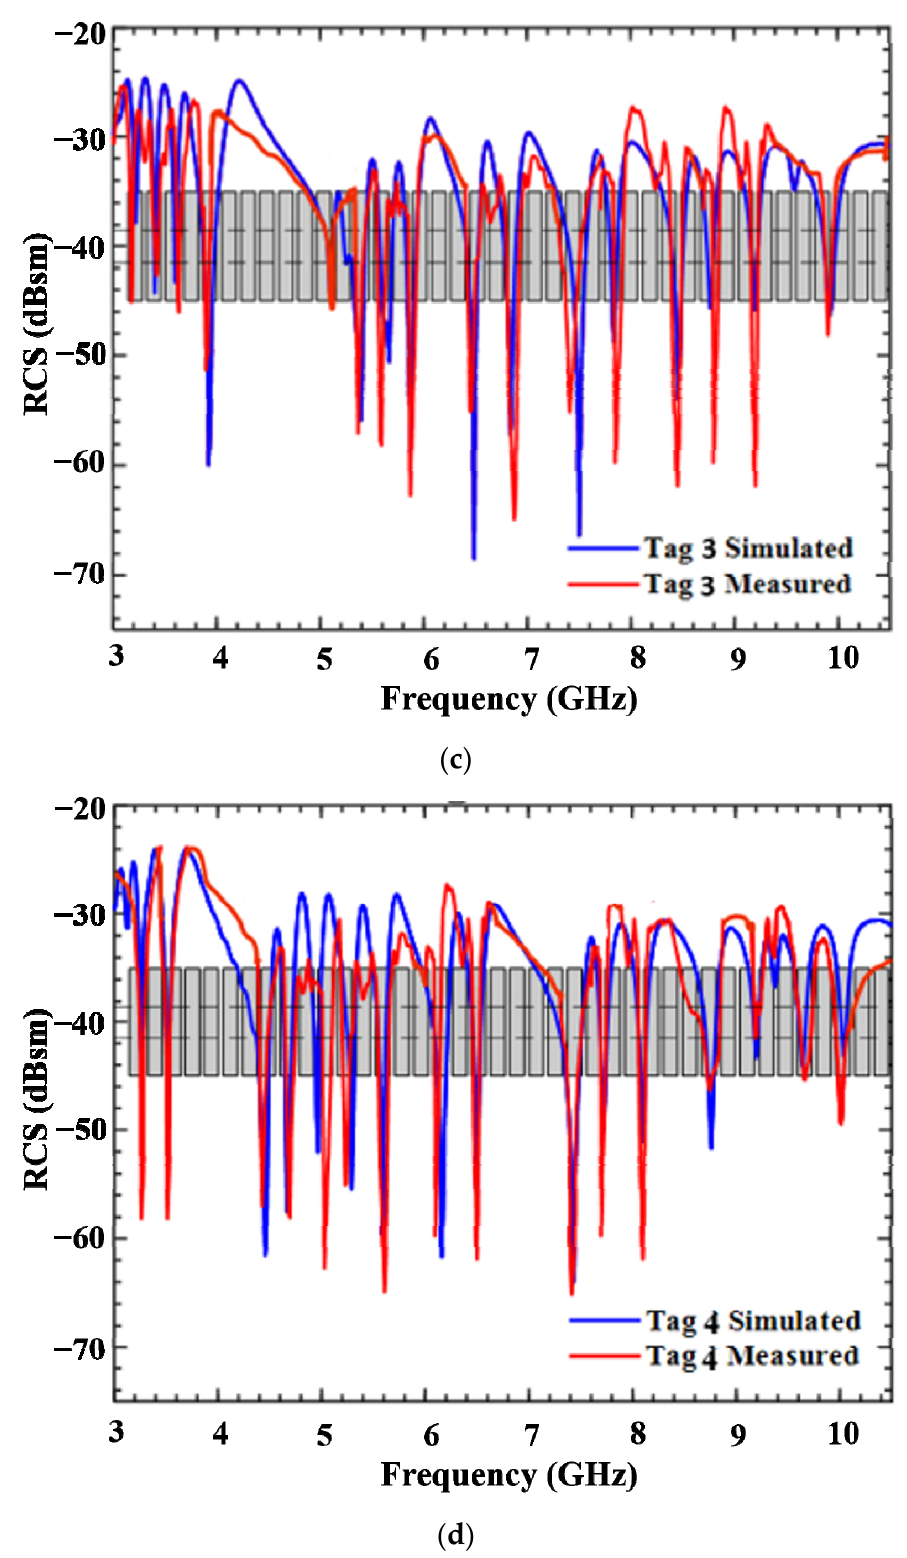
Figure 9. The measured RCS responses of CRFID tag: ( a ) Tag 1; ( b ) Tag 2; ( c ) Tag 3; ( d ) Tag 4.